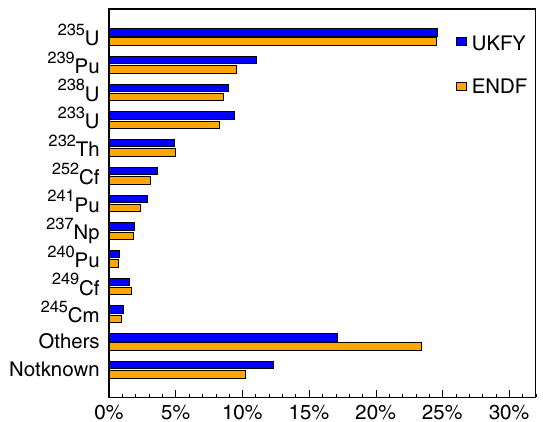
“Not FPY”. The reference is for regular retroactive EX- FOR compilation by NRDC.